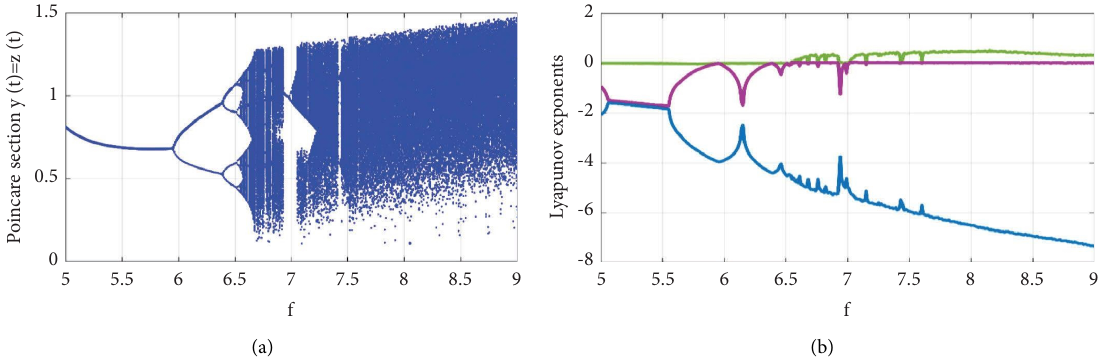
Figure 6: (a) Te system bifurcation diagram and (b) the corresponding Lyapunov exponents, utilizing f as a bifurcation parameter with fxing the other parameters constant such that a � 2 ,b � 7 , c � 5 , g � 11 , and r � 4. 00.511.5